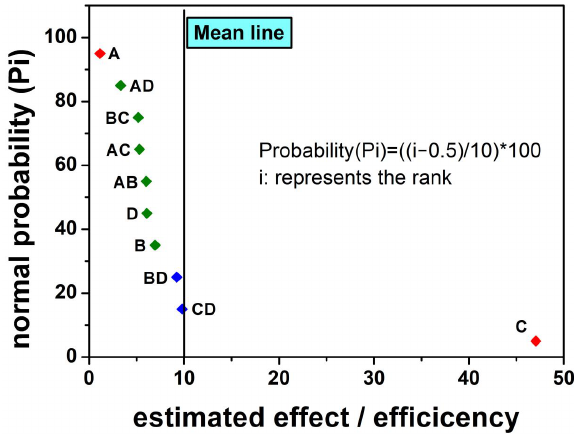
Figure 3. Normal probability plot for the distribution of individual and interaction effects of the four tested variables with their three levels on the CR4 steel protection in salt water using inhibitor O. The following color code applies: Red for high, green for good to medium, and of blue for negligible effects, respectively, of the tested variable on the